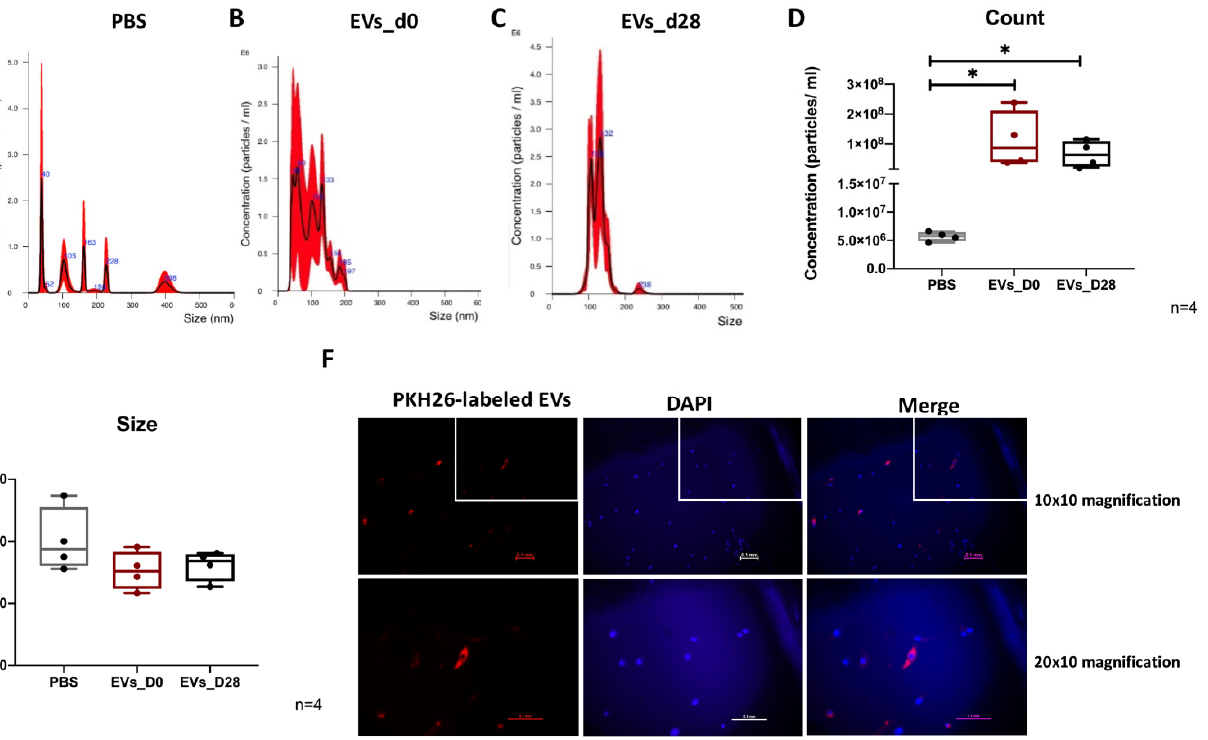
Figure 2. Molecular characterization of EVs. ( A – C ) Particle size distribution of PBS, naïve hBMSCs- EVs and osteogenic EVs was measured by NTA analysis. n = 4. ( D , E ) Quantitative comparison among PBS, naïve hBMSCs-EVs and osteogenic EVs in count and size measured by NTA analysis. n = 4. * p < 0.05; two-tailed Mann–Whitney U-test was used to compare differences between different groups. ( F ) Uptake of EVs by hBMSCs. PKH26-labeled EVs_D28 (red) were internalized by hBMSCs and visualized with fluorescence microscopy. Cell nuclei were stained with DAPI. Scale bar: 100 µ m. n = 2.